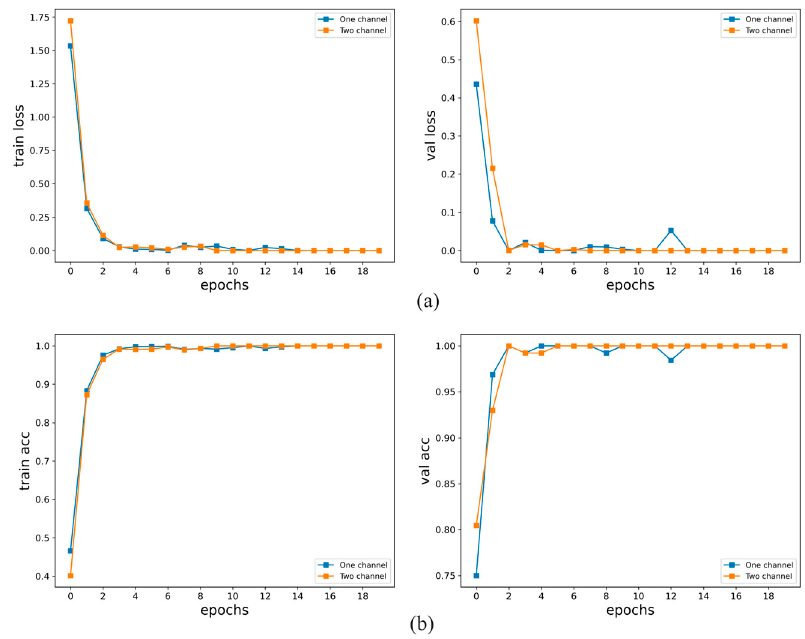
Figure 15. Training results of single-channel data and two-channel data in the CWRU dataset using the STFT method: ( a ) Train loss and val loss, ( b ) Train acc and val acc.